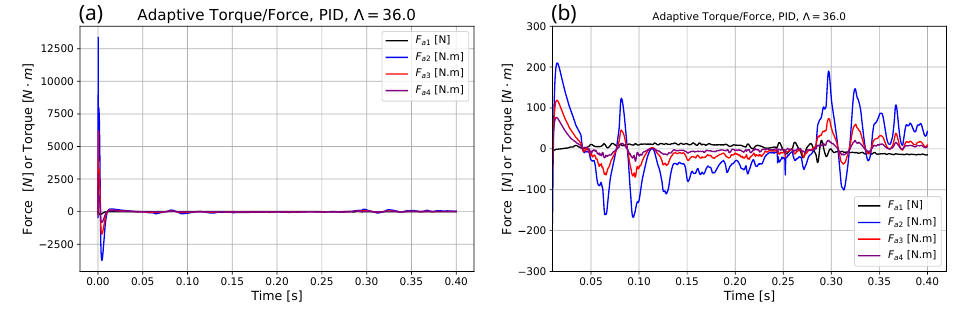
Figure 19. Second time-derivatives without force limitation for the increased α min = 0.1 for the joint coordinates q 3 ( t ) and q 4 ( t ) . ( a ) In full scale. ( b ) Without the initial transient.